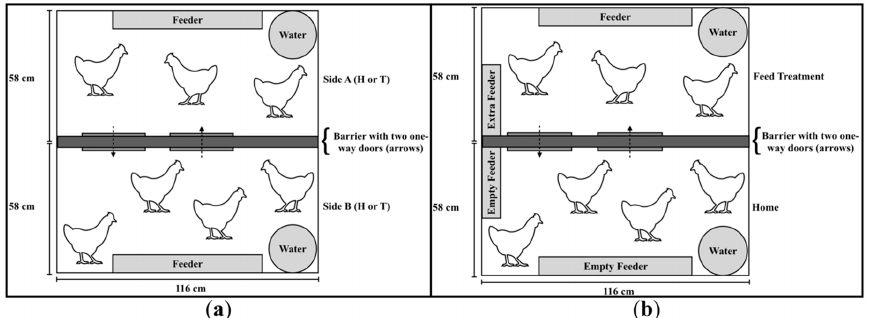
Figure 2. Experimental setup of broiler chick floor pens. Each pen contained two compartments (H and T) separated by a barrier with two unidirectional push doors that could be loaded to 10%, 20%, or 30% of the pen’s median chick body weight. T and H alternated between Side B or Side A to avoid side bias. ( a ) Pen setup when testing substrates (soiled pine and spruce shavings, soiled pine and spruce shavings treated with an ammonia reductant, fresh pine and spruce shavings, and fresh aspen shavings). ( b ) Pen setup when testing feed treatment.